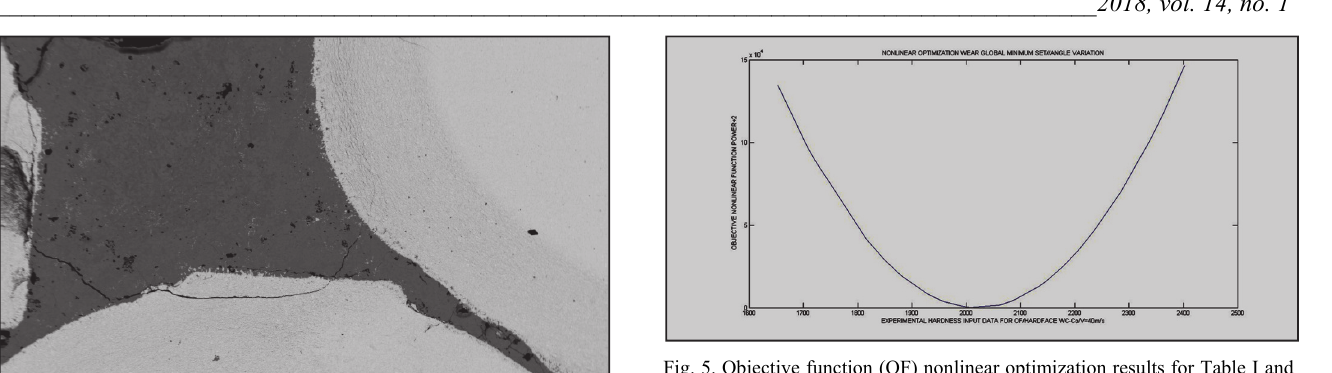
Fig. 5. Objective function (OF) nonlinear optimization results for Table I and Eq. (2) model, Matlab 2009-12. The impact velocity is 40 m/s. Results are acceptable with a Global Minimum sharply determined and running time is lower than a second.